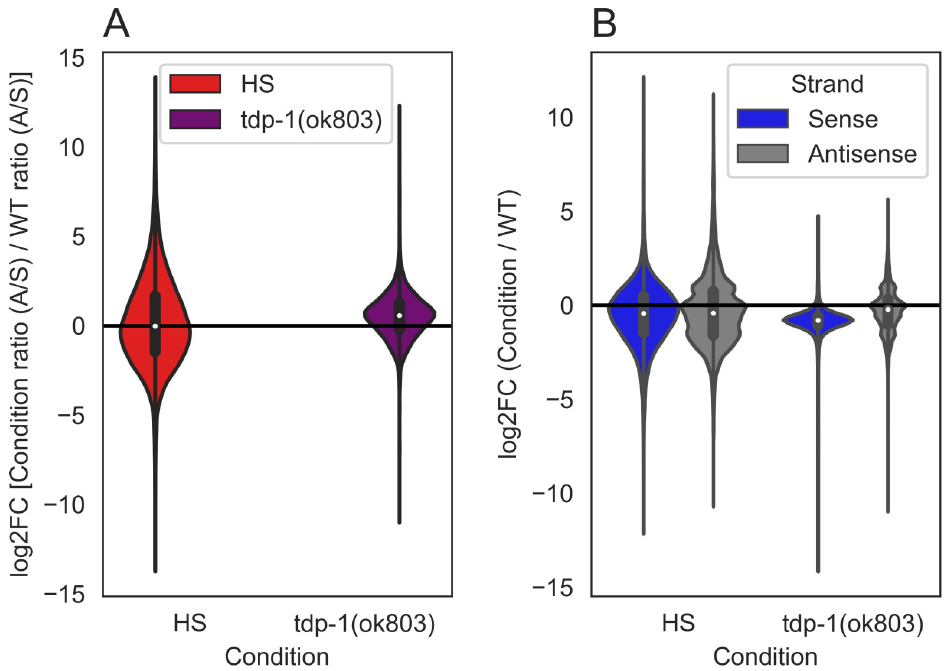
Fig 2. Quantification of genes with changes in antisense/sense ratios after heat shock or deletion of tdp-1 in input RNA. Violin plots of the ratio of read counts over gene regions for each condition compared to wild type (WT) [mean > 20 for pooled counts (sense and antisense, condition and wild type), n = 1]. (A) With heat shock 5513/11091 genes have a higher antisense/sense ratio compared to wild type (log2FC > 0, area of red violin plot above the black line). With tdp-1(ok803 ) 7551/10831 genes have a higher antisense/sense ratio compared to wild type (log2FC > 0, area of purple violin plot above the black line). (B) With heat shock, 4125/11091 sense and 3679/11091 antisense transcripts are upregulated compared to wild type (log2FC > 0, area of violin plot above the black line). With tdp-1(ok803 ) 419/ 10831 sense and 3301/10831 antisense transcripts are upregulated compared to wild type.